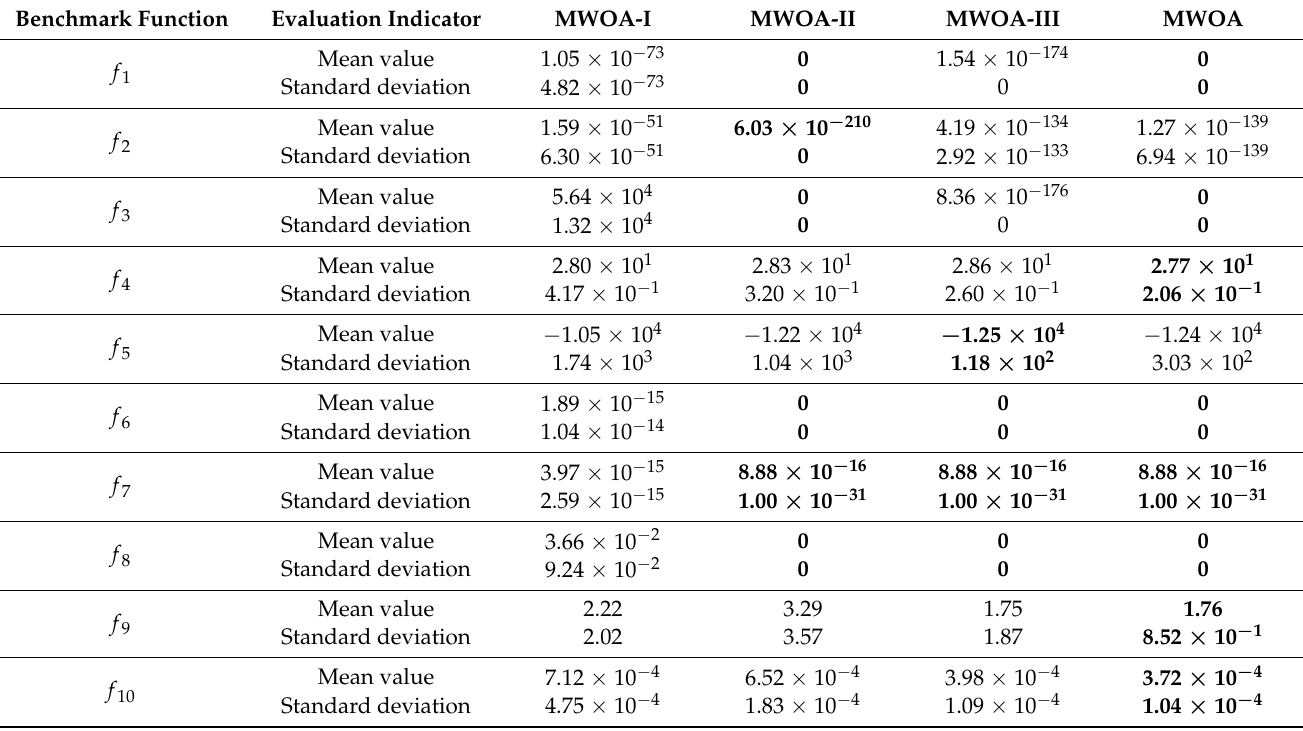
Table 3. Comparison of performance improvement effect of each improvement